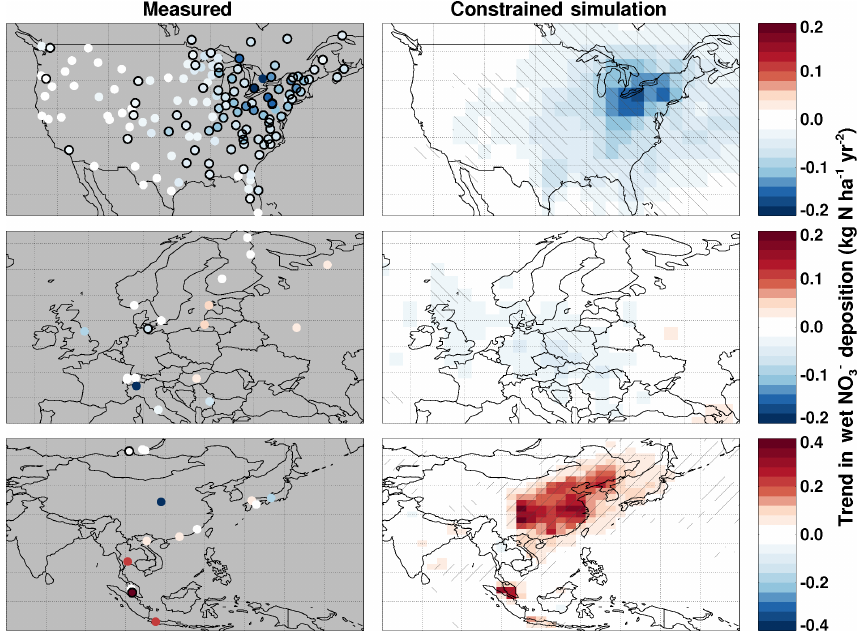
Figure 7. Long-term (1996–2014) trends in wet NO − deposition from available regional network measurements (as in Fig. 4) and from the 3 GEOS-Chem simulation, constrained by satellite observations of NO 2 . Closed circles around the measurements indicate significant trends ( p <0.01); hatching indicates statistical significance in the